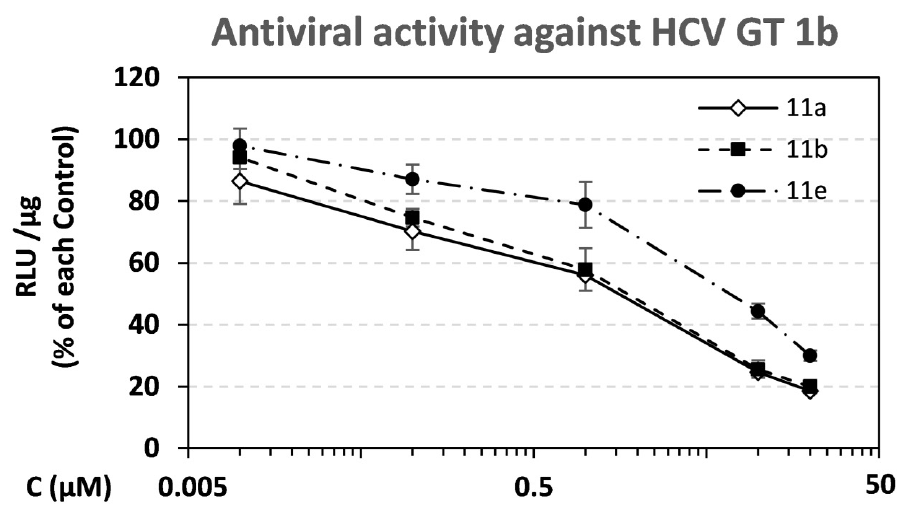
Figure 3. Dose–response curves for compounds 11a , 11b , and 11e against replication of HCV GT 1b. Serial dilutions of compounds were used to treat Huh5-2 replicon cells for 72 h. F-Luc activity was measured and expressed as relative light units (RLUs) per µ g of total protein. Values from compound-treated cells were expressed as percentage of the ones from solvent-treated DMSO (control) cells. Bars represent mean values from 3 independent triplicate experiments. Error bars represent standard deviation (SD).